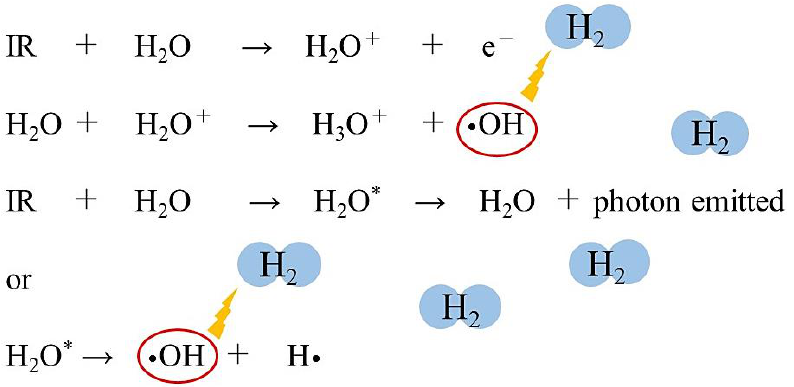
Figure 1. Ionizing radiation (IR) acts on water, a component of living organisms, ionizing and exciting the water molecules. Short-lived radical-cations (H 2 O + ) are very unstable and decompose to produce hydroxyl radicals (•OH) and hydronium (H 3 O + ). Electronically excited water molecules